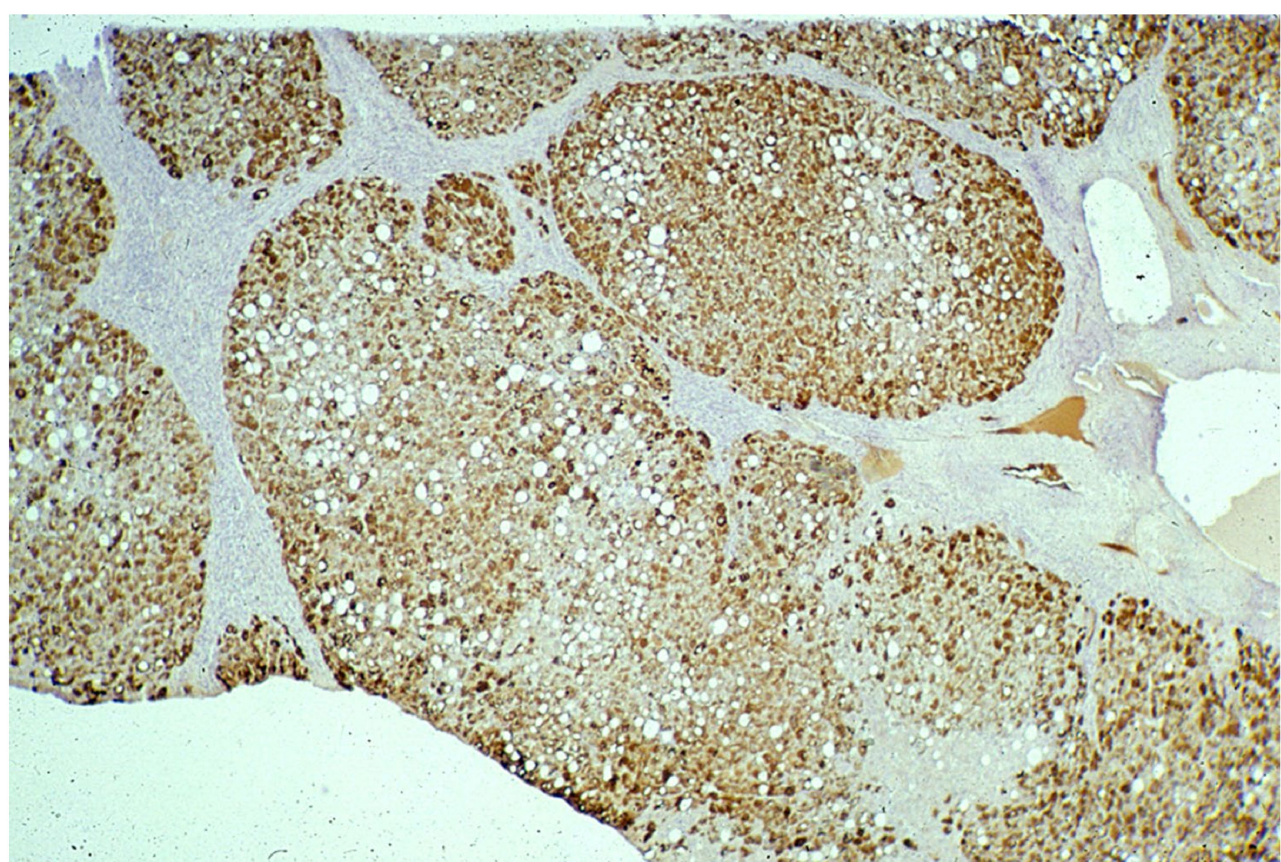
Figure 15. HHHS cirrhotic liver. Fibrinogen inclusions are present in all parenchymal nodules. The immunoreaction appears in the whole cytoplasm. In the central part of the smallest nodule, the positivity appears at the periphery of the cells, beneath the plasma membrane (polyclonal fibrinogen immunostaining ×